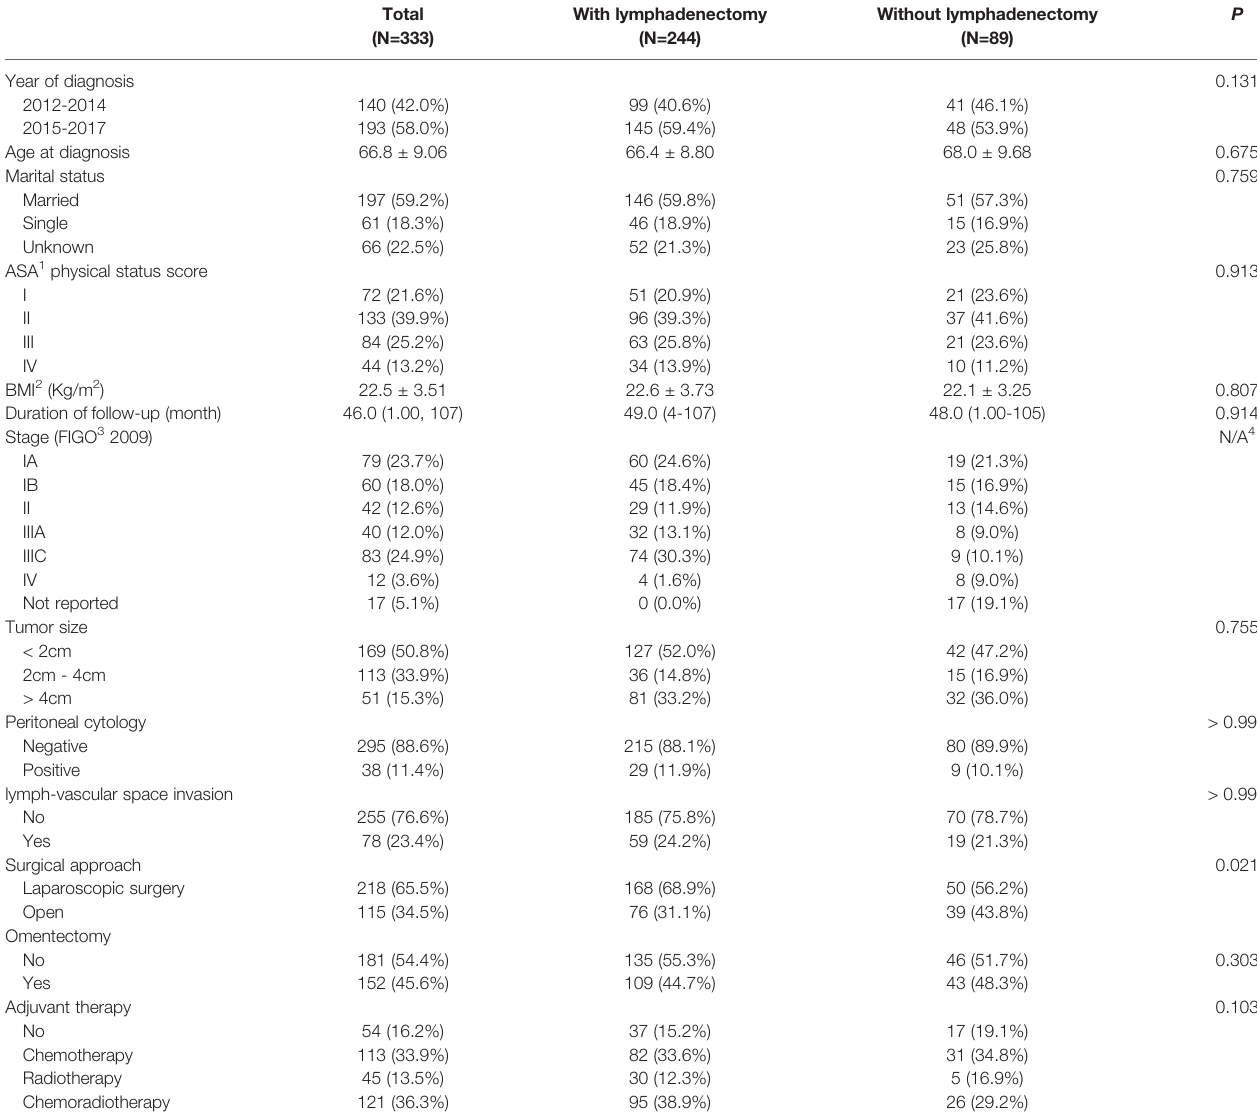
TABLE 1 | Demographics and Baseline Characteristics of the study cohort.